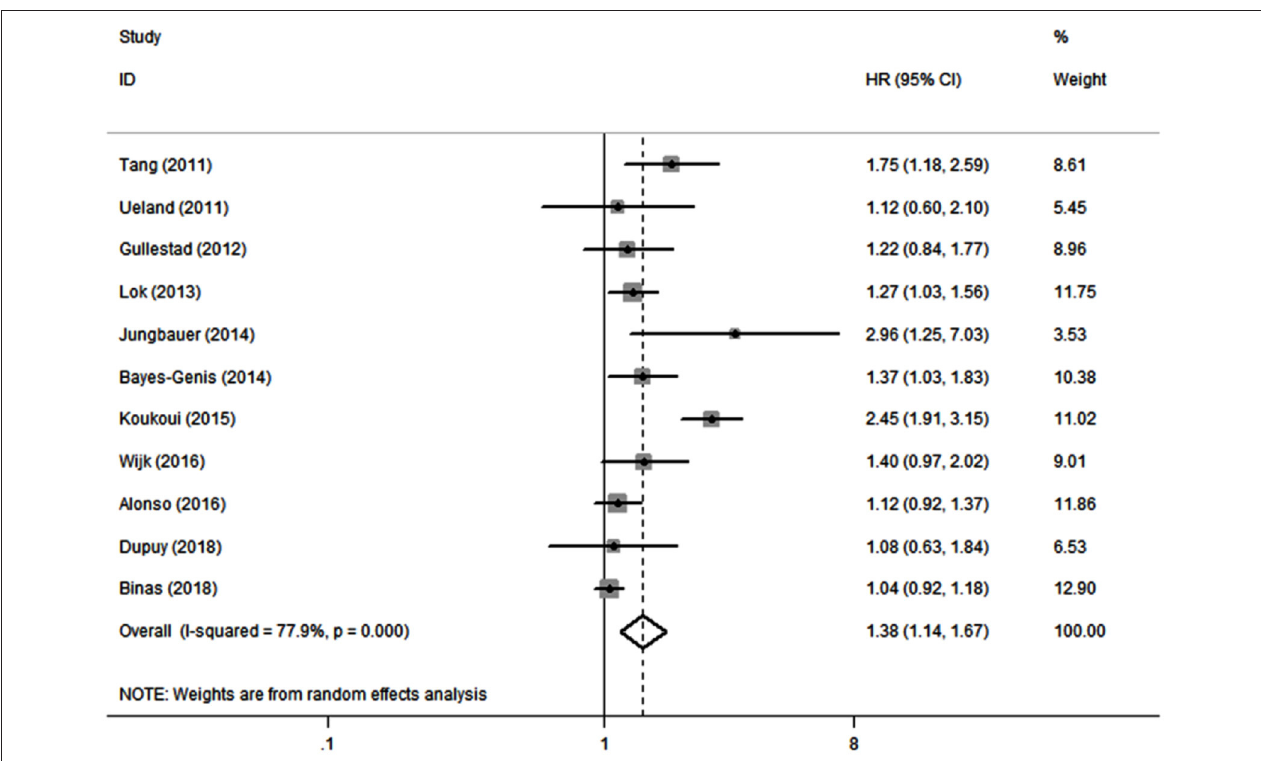
FIGURE 3 | Meta-analysis of the association between galectin-3 and risk of ACD in CHF patients. Results are presented as individual and pooled HR, and 95% CI.